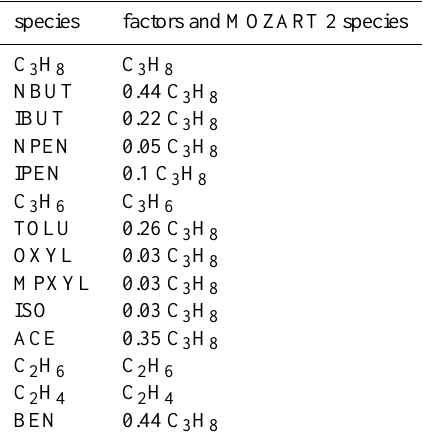
Table 3. Factors applied to MOZART 2 explicit species concentra- tions to determine the initial and boundary conditions of the model species.